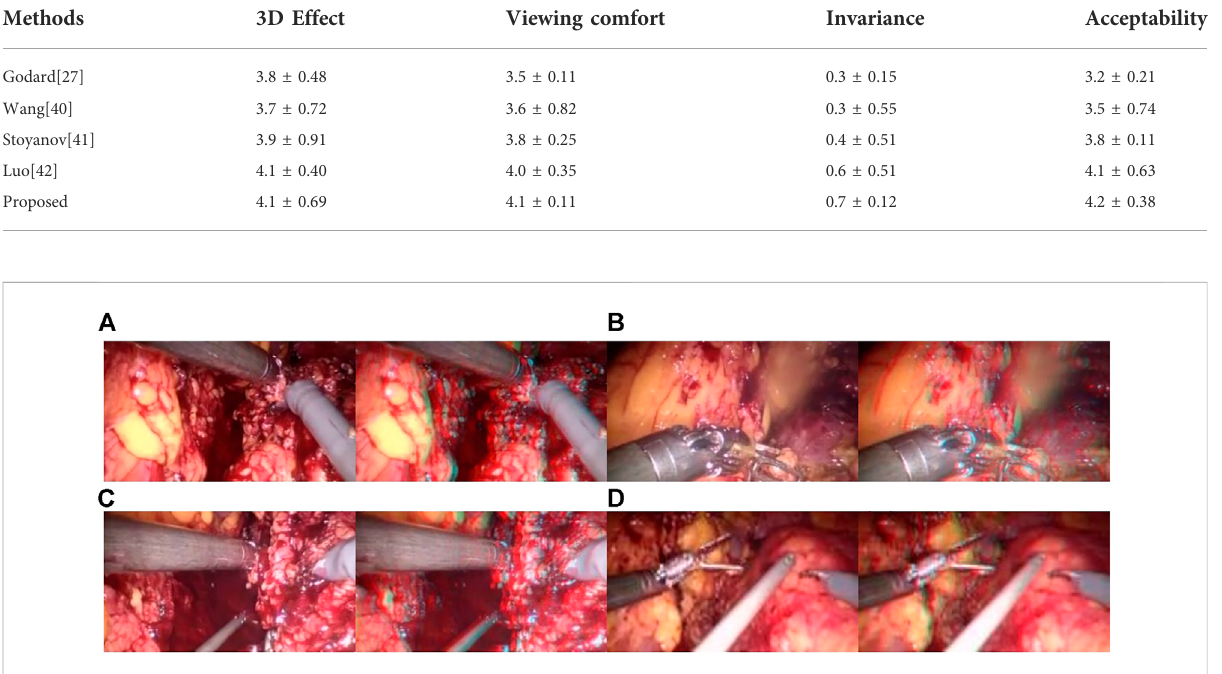
TABLE 6 Subjective evaluation and comparison of the 3D reconstruction effect. (Mean ± STANDARD, deviation).